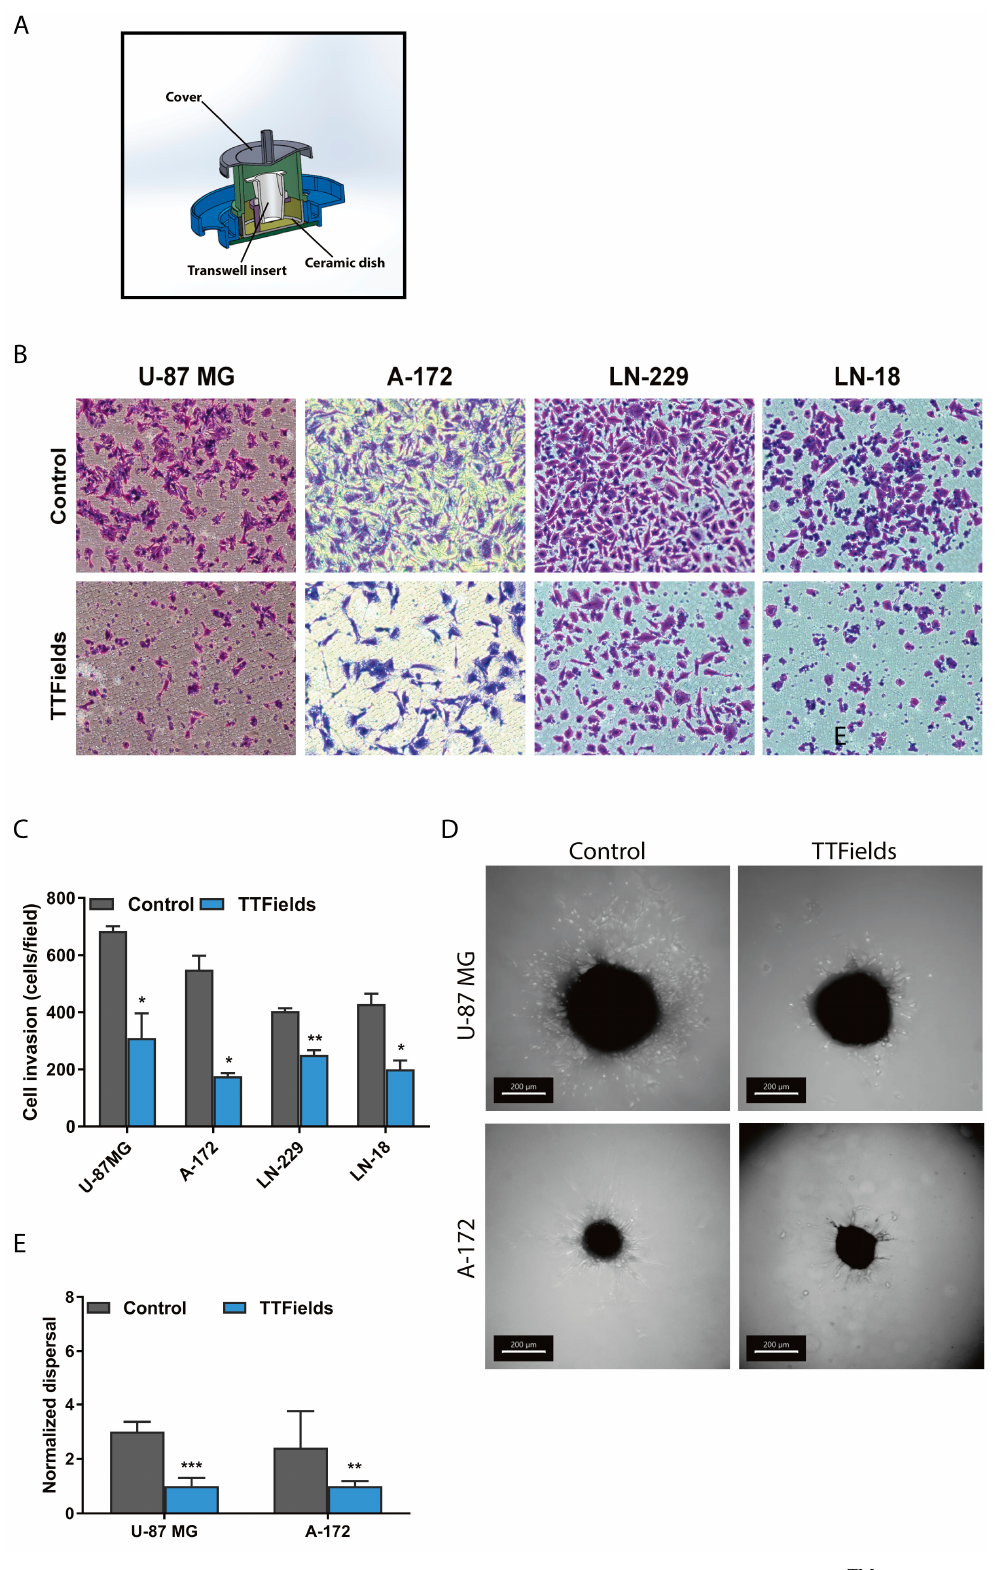
Figure 1. Tumor Treating Fields (TTFields) reduce cancer cell invasion. ( A ) The inovitro TM system with extended wall dish. ( B ) Invasion properties of U-87 MG, A-172, LN-229 and LN-18 glioblastoma cells were evaluated by the modified Boyden chamber assay in the presence of TTFields. Top panel—control cells, bottom panel-TTFields-treated cells (magnification × 100). ( C ) Quantification of invading cells. ( D ) Spheroid dispersal assay of U-87 MG and A-172 spheroids (scale bar: 200 µ m). ( E ) Quantification of spheroid dispersal. Mean + SEM; paired t -test. * p < 0.05, ** p < 0.01, and *** p <